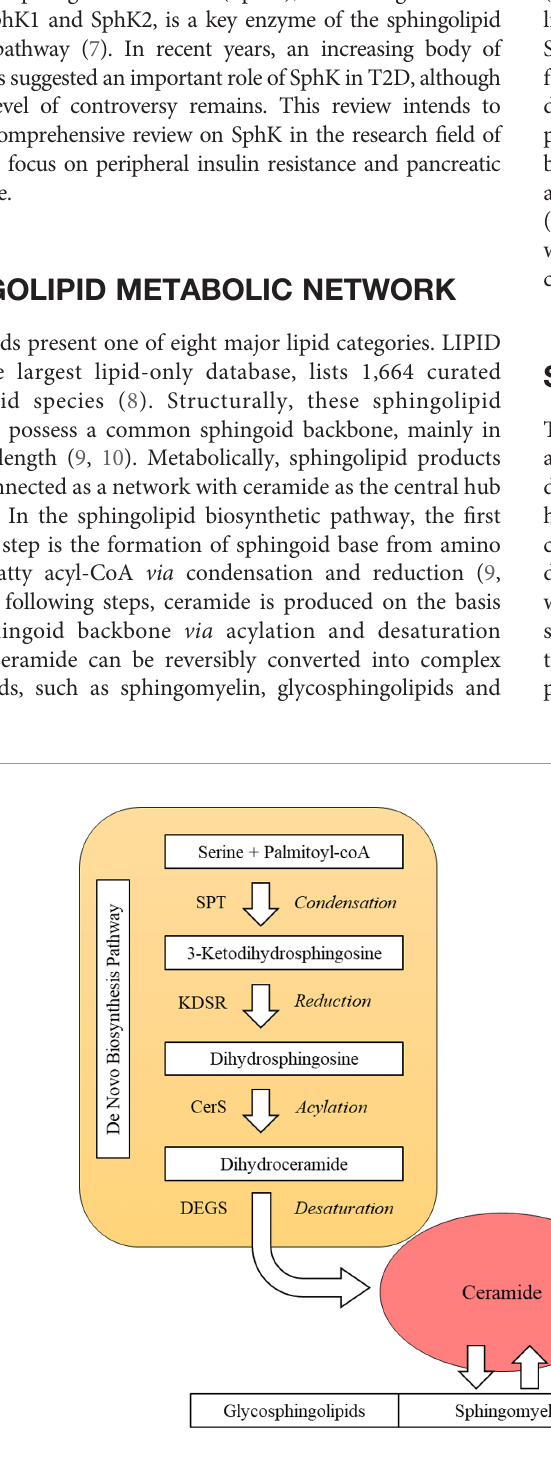
FIGURE 1 | Sphingolipid metabolic network. SPT, serine palmitoyltransferase; KDSR, 3-keto-dihydrosphingosine reductase; CerS, ceramide synthase; DEGS, dihydroceramide desaturase; CDase, ceramidase; SphK, sphingosine kinase; SPGL1, sphingosine 1-phosphate